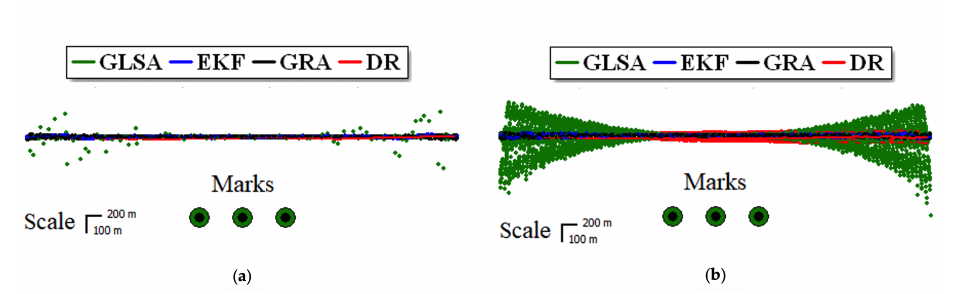
Figure 6. Position accuracy areas are used to determine alignment of beacons and estimated SV positions relative to them during: ( a ) single crossing, ( b ) 100 crossings.